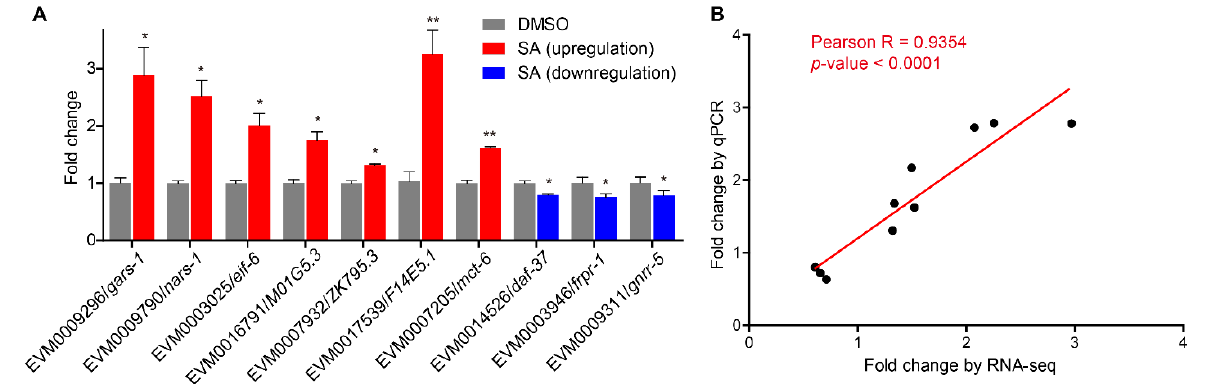
Figure 7. Validation of the RNA-seq results using qPCR. ( A ) qPCR analysis of interest genes identified from the RNA-seq results. Fold changes indicate the ratio of the SA (stearic acid) supplementation group to the control DMSO group. The error bars represent SEM of the mean, * p < 0.05, ** p < 0.01, two-sided t -test. ( B ) Correlation analysis of the results of RNA-seq and qPCR for detected genes. Each dot represents a gene, with detailed information shown in Supplementary File S4. Correlation analysis was performed using GraphPad Prism 5 software, Pearson R = 0.9354, with a p -value < 0.0001.